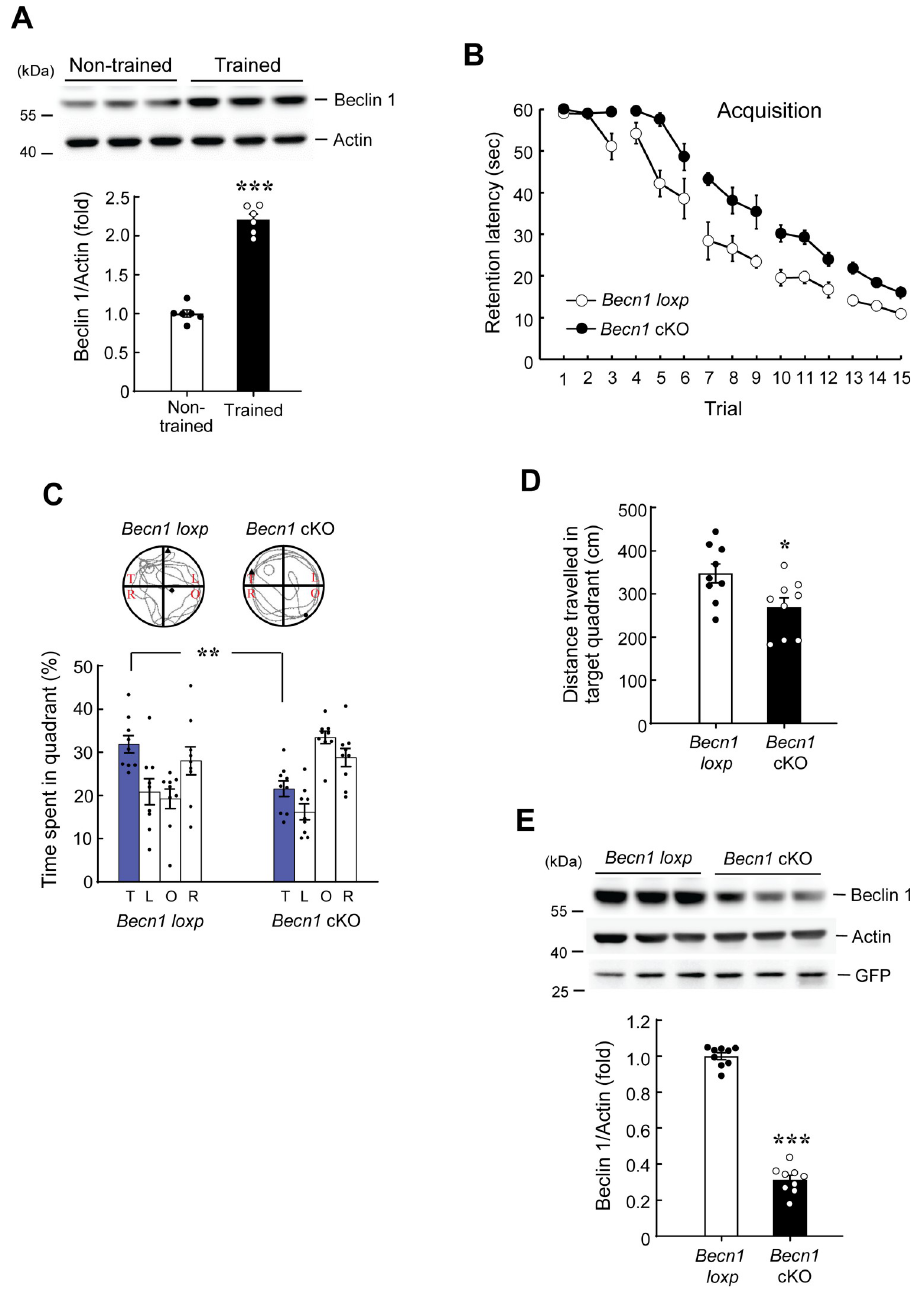
Fig 4. Spatial training increases Beclin 1 expression, and spatial learning and memory is impaired in Becn1 cKO mice. (A) Rats were subjected to water maze training or swimming control (non-trained) and were sacrificed three days later. Their CA1 tissue was subjected to western blot determination of Beclin 1 expression (N = 6 each group, the same animals in Fig 1F). Water maze training increased Beclin 1 expression level (t 1,10 = 11.95, p < 0.001). (B) The Becn1 loxp mice (that received lenti-GFP vector transduction) and Becn1 cKO mice (that received lenti-GFP- 2A-NLS-Cre vector transduction) were subjected to water maze learning two weeks after lentivirus transduction. The Becn1 cKO mice showed impaired acquisition performance (N = 9 each group) (F 1,16 = 33.75, p < 0.001). (C) Probe trial performance (t 1,16 = 3.79, p < 0.01 for the target quadrant) and (D) Distance travelled in the target quadrant (t 1,16 = 2.55, p < 0.05) from the same animals as that in (B). The Becn1 cKO mice showed impaired retention performance and made less travelling in the target quadrant than the Becn1 loxp mice. (E) The Beclin 1 expression level is decreased in the Becn1 cKO mice than the Becn1 loxp mice (t 1,16 = 22.16, p < 0.001). The GFP expression level is similar for these two groups of mice. Data are expressed as individual values and mean ± SEM. * p < 0.05, ** p < 0.01 and *** p <